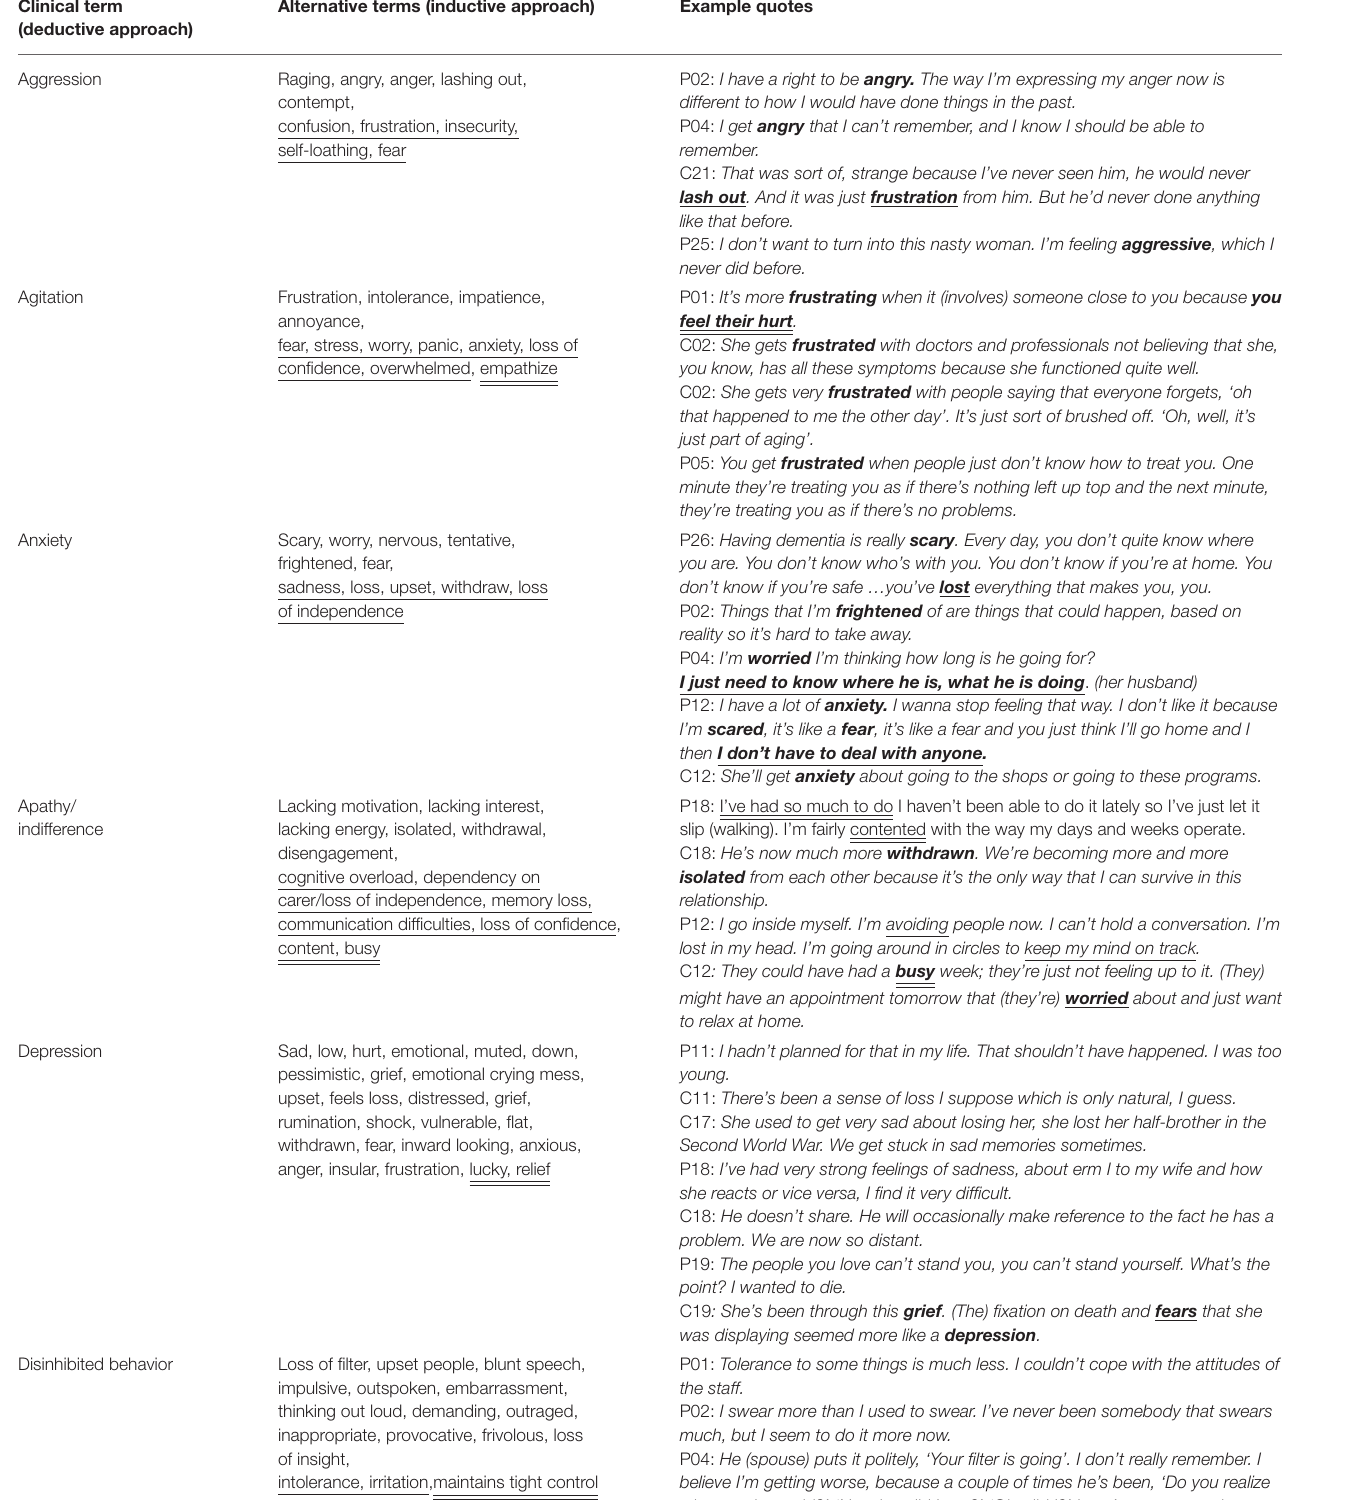
TABLE 3 | Terminology * used to describe individual behavioral and psychological symptoms of dementia (BPSD) by people with lived experience. Clinical term (deductive